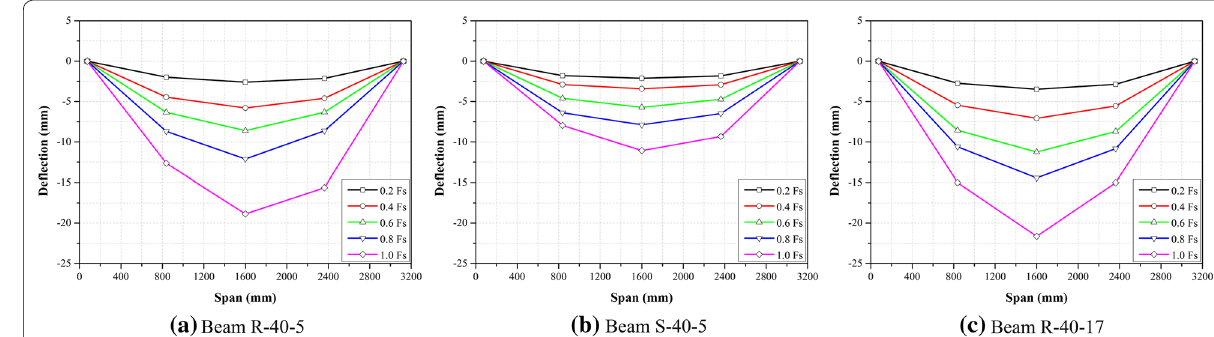
Fig. 7 Deflection along typical composite concrete beams under load.